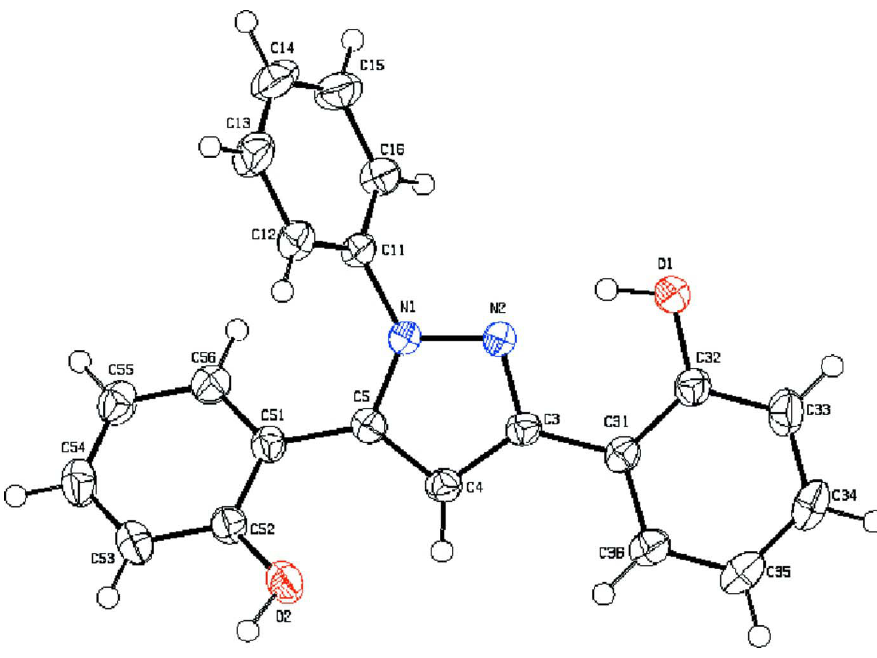
Figure 1 Molecular structure of the title compound. Displacement ellipsoids are drawn at the 50% probability